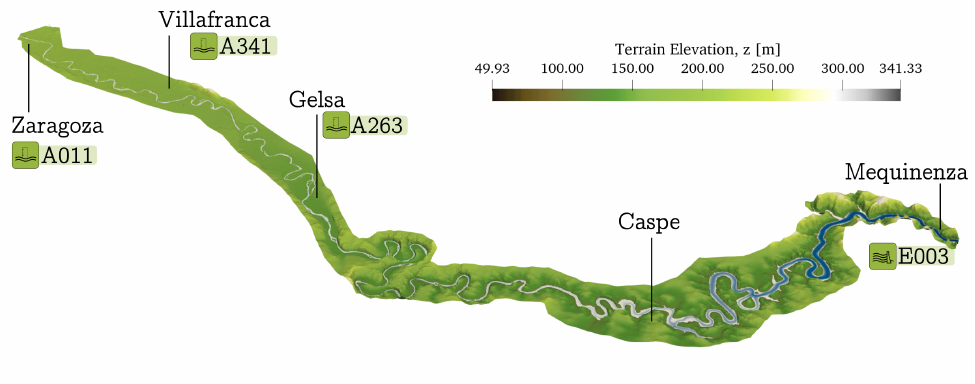
Figure 2. Representation of the 2D simulation domain of the Ebro River with the most important cities and gauging stations of CHE. The labels correspond to the official names of the gauging stations. Two historical events of the Ebro River, the 2015 and the 2018 floods, have been identified as relevant. Information concerning discharge hydrographs as well as time evolution of the water surface level are available at the gauging stations. Additionally, the European Emergency System (EMS) provides data of flooded area extensions, as seen in Figure 3 (https://emergency.copernicus.eu/; accessed on 20 October 2021). This helped to choose the domain extension setting the boundaries far enough not to interfere the flow.